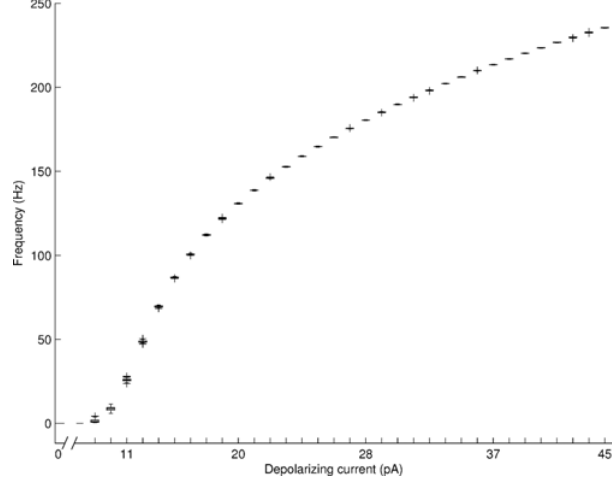
Figure 1. Gating variables for K A channel activation and inactivation processes. The stochastic model is simulated for 0.5 seconds and depolarized from 0.15 seconds to 0.35 seconds. The value of the parameter s is set to 0.15 and all other parameters are fixed as explained in the text. doi:10.1371/journal.pcbi.1000004.g001 stochastic component would result in negative values of the gating variable. Hence, we have to use small values of parameter s or use